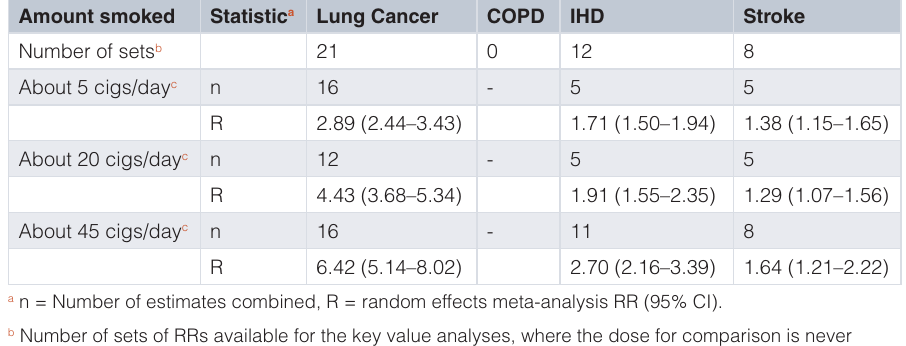
Table 4. Meta-analysis for amount smoked by current smokers.